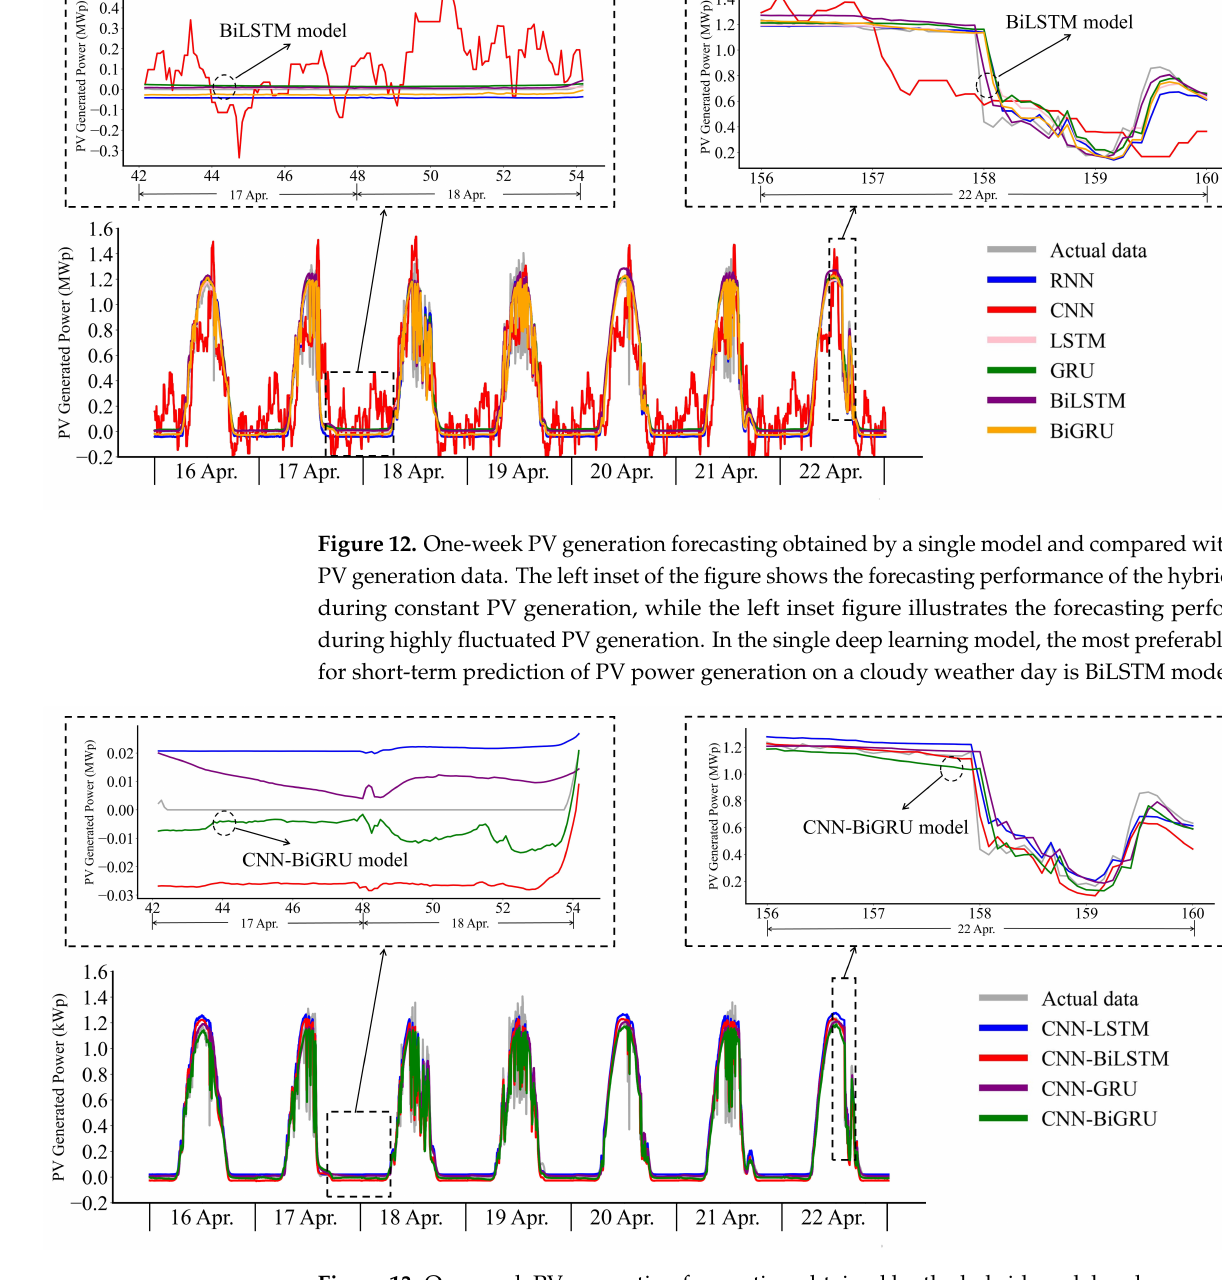
Figure 13. One-week PV generation forecasting obtained by the hybrid model and compared with actual PV generation data. The left inset figure show the forecasting performance of the hybrid model during constant PV generation, while the left inset of the figure illustrates the forecasting performance in highly fluctuated PV generation. In the hybrid deep learning model, the most preferable model for the short-term prediction of PV power generation on a cloudy weather day is CNN-BiGRU